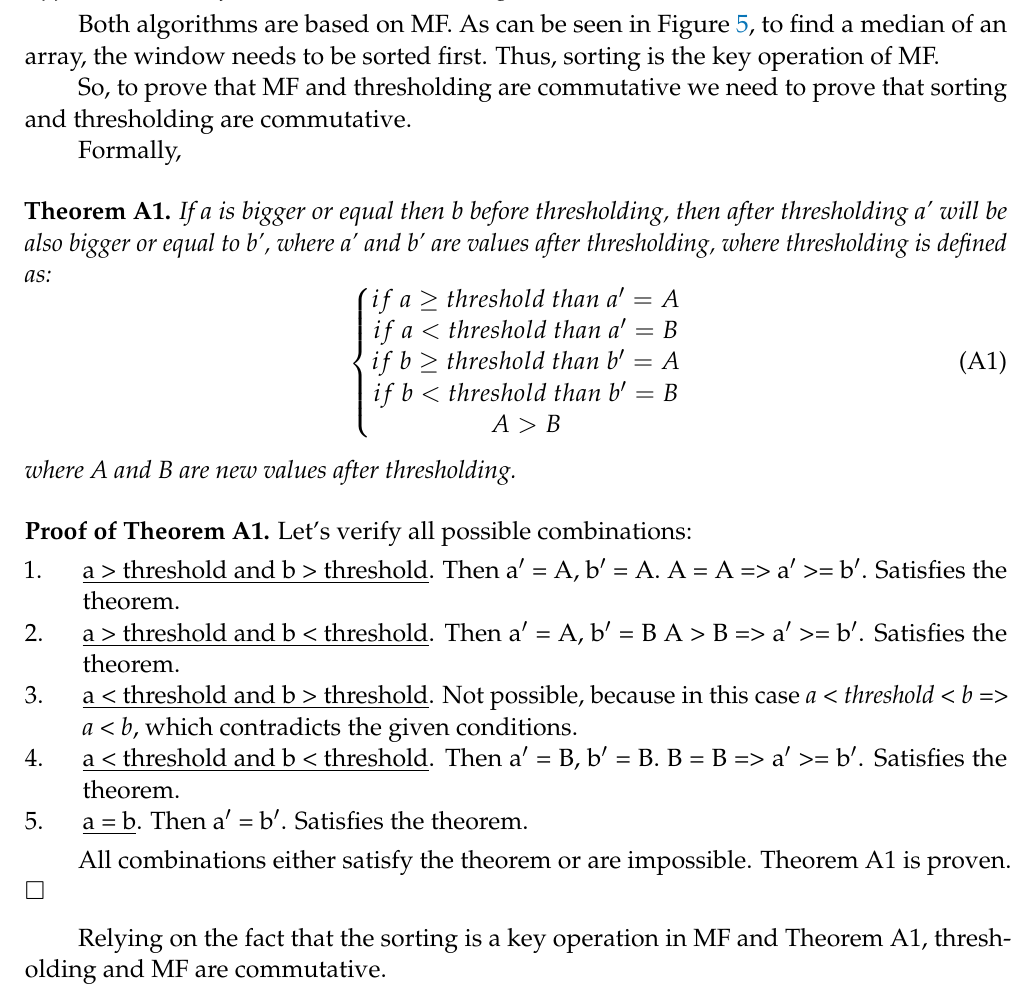
Figure A3. The steps that formally constitute each post-processing algorithm.